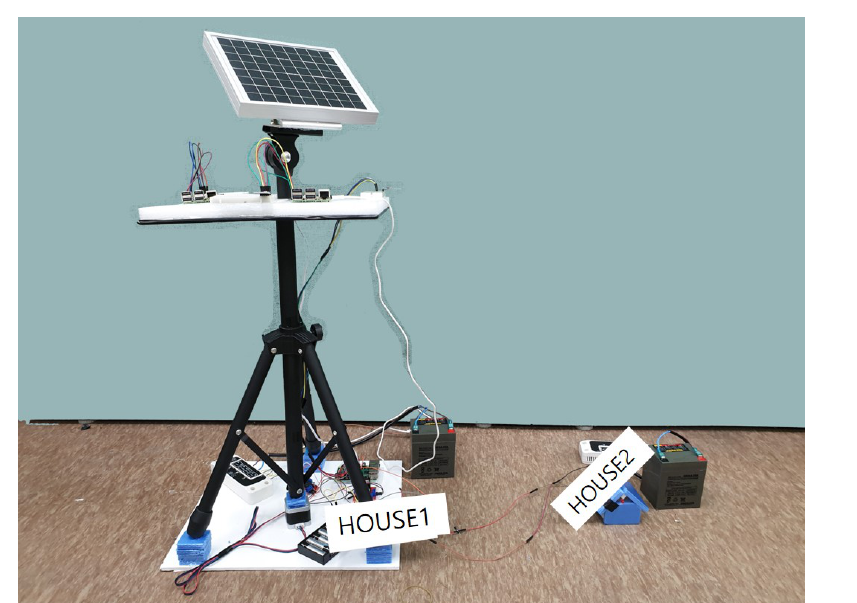
Figure 5. Blueprint of controllers in testbed.